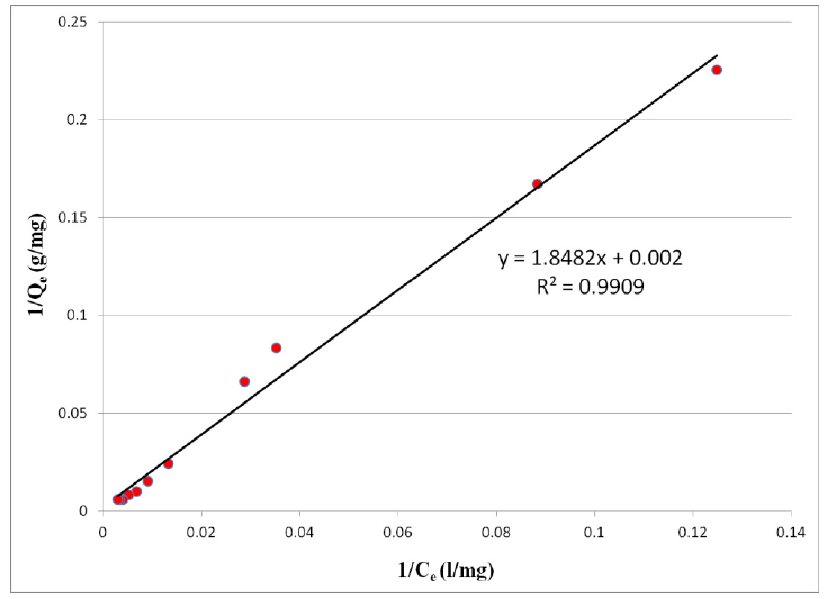
Figure 6. Langmuir plot for adsorption of Cr(VI) onto